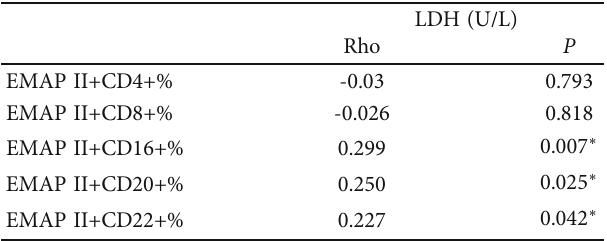
Table 3: Correlation of EMAP II expression in di ff erent blood cells and LDH levels in NHL